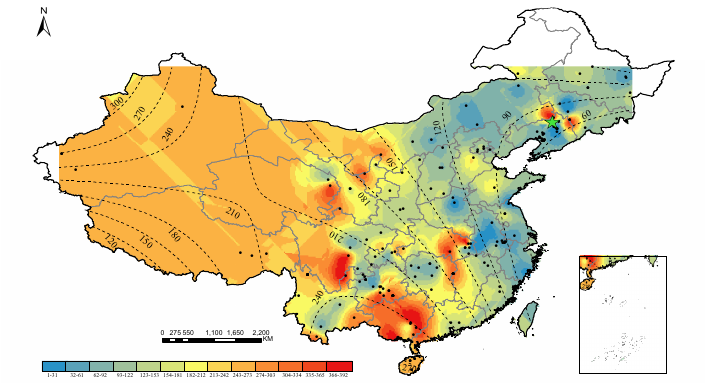
Figure 8. Spatial prediction map for the ordinary kriging interpolation of the duration of ASF spread in Mainland